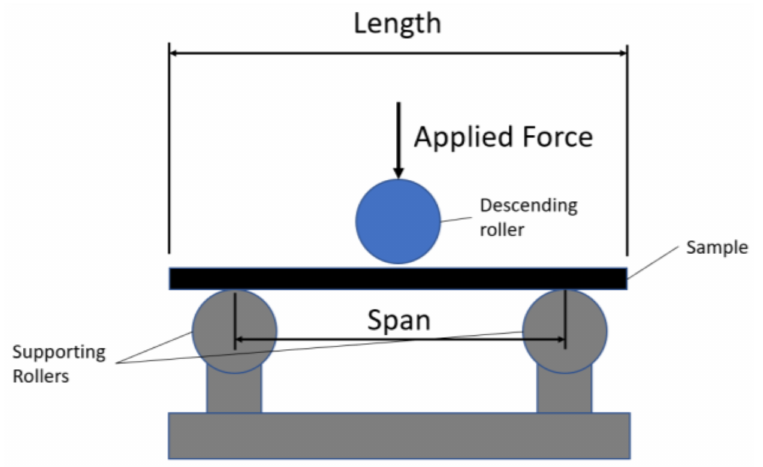
Figure 5. Three-point bending illustration. Supports and loading rollers of radius 5 of 13.76 mm/min, in accordance with Equation (7), for a strain rate of 0.01 mm/min and 5.16 mm average sample